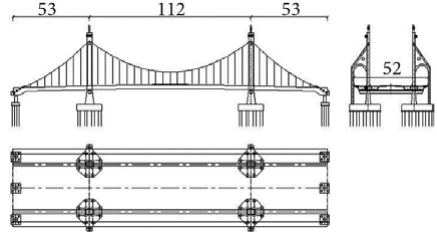
Fig. 5. General layout (unit in metres)